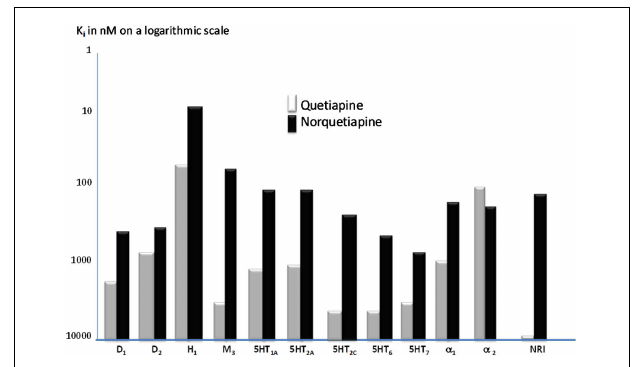
FIGURE 1 | Binding affinities of quetiapine (white bars) and its metabolite N -Desalkylquetiapine (dark bars) at the tested panel of brain receptors neurotransmitter transporters ( K i in nanomoles on a logarithmic scale). Modified to Jensen et al. (49).